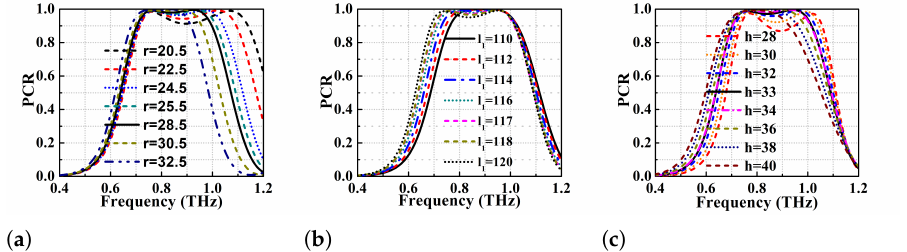
Figure 10. Simulated PCR of the proposed PC at different ( a ) radius of the ring µ m ( b ) strip length ( l 1 ) µ m ( c ) height of the dielectric substrate µ